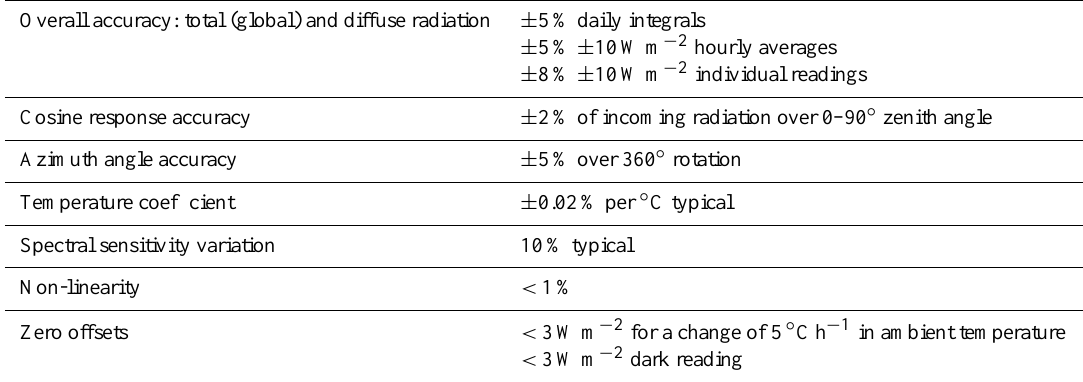
Table 1. SPN1 nominal specifications (Delta-T Devices Ltd, 2007). Overall accuracy: total (global) and diffuse